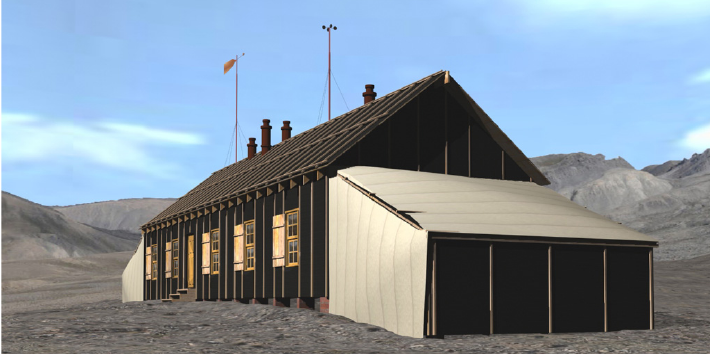
Figure 6. Computer reconstruction of the Greely station